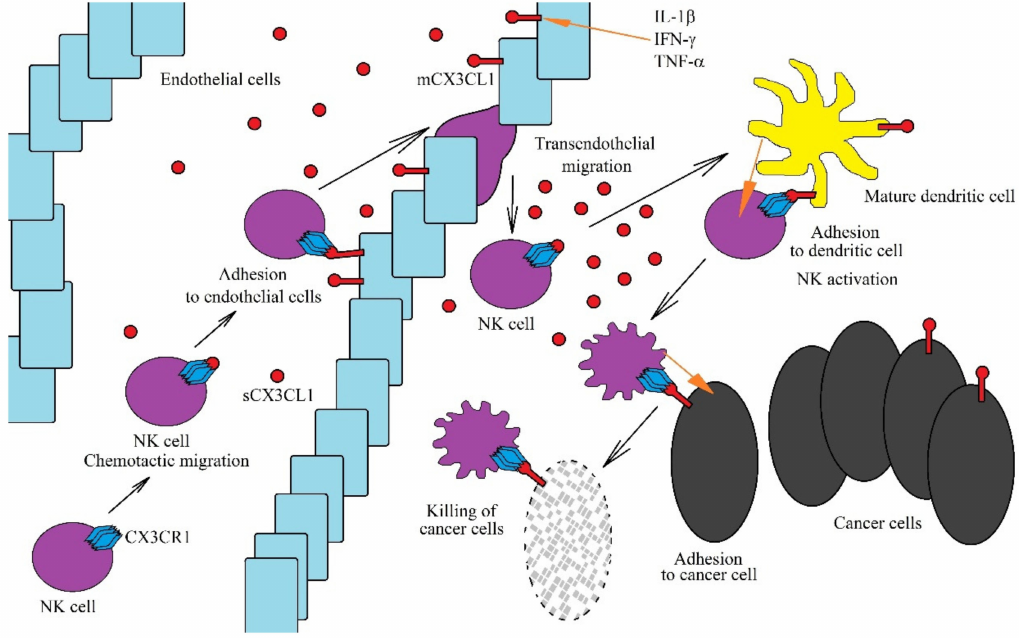
Figure 2. Role of the CX3CL1-CX3CR1 axis in anti-cancer NK cells functions. The CX3CL1-CX3CR1 axis plays an important role in the anti-tumor functions of NK cells at many levels. CX3CL1 expression is increased by the proinflammatory cytokines IL-1 β , IFN- γ and TNF- α . A sCX3CL1 gradient is formed, which causes chemotactic migration of NK cells. On endothelial cells near the tumor, mCX3CL1 acts as an adhesive protein for NK cells. This enables the transendothelial migration of NK cells to sites of intensive immune response, where they are activated by mature dendritic cells. However, for NK cells to be activated e ff ectively, chemotaxis and adhesion of these cells to mature dendritic cells is required, which is dependent on the CX3CL1-CX3CR1 axis. Activated NK cells destroy cancer cells.